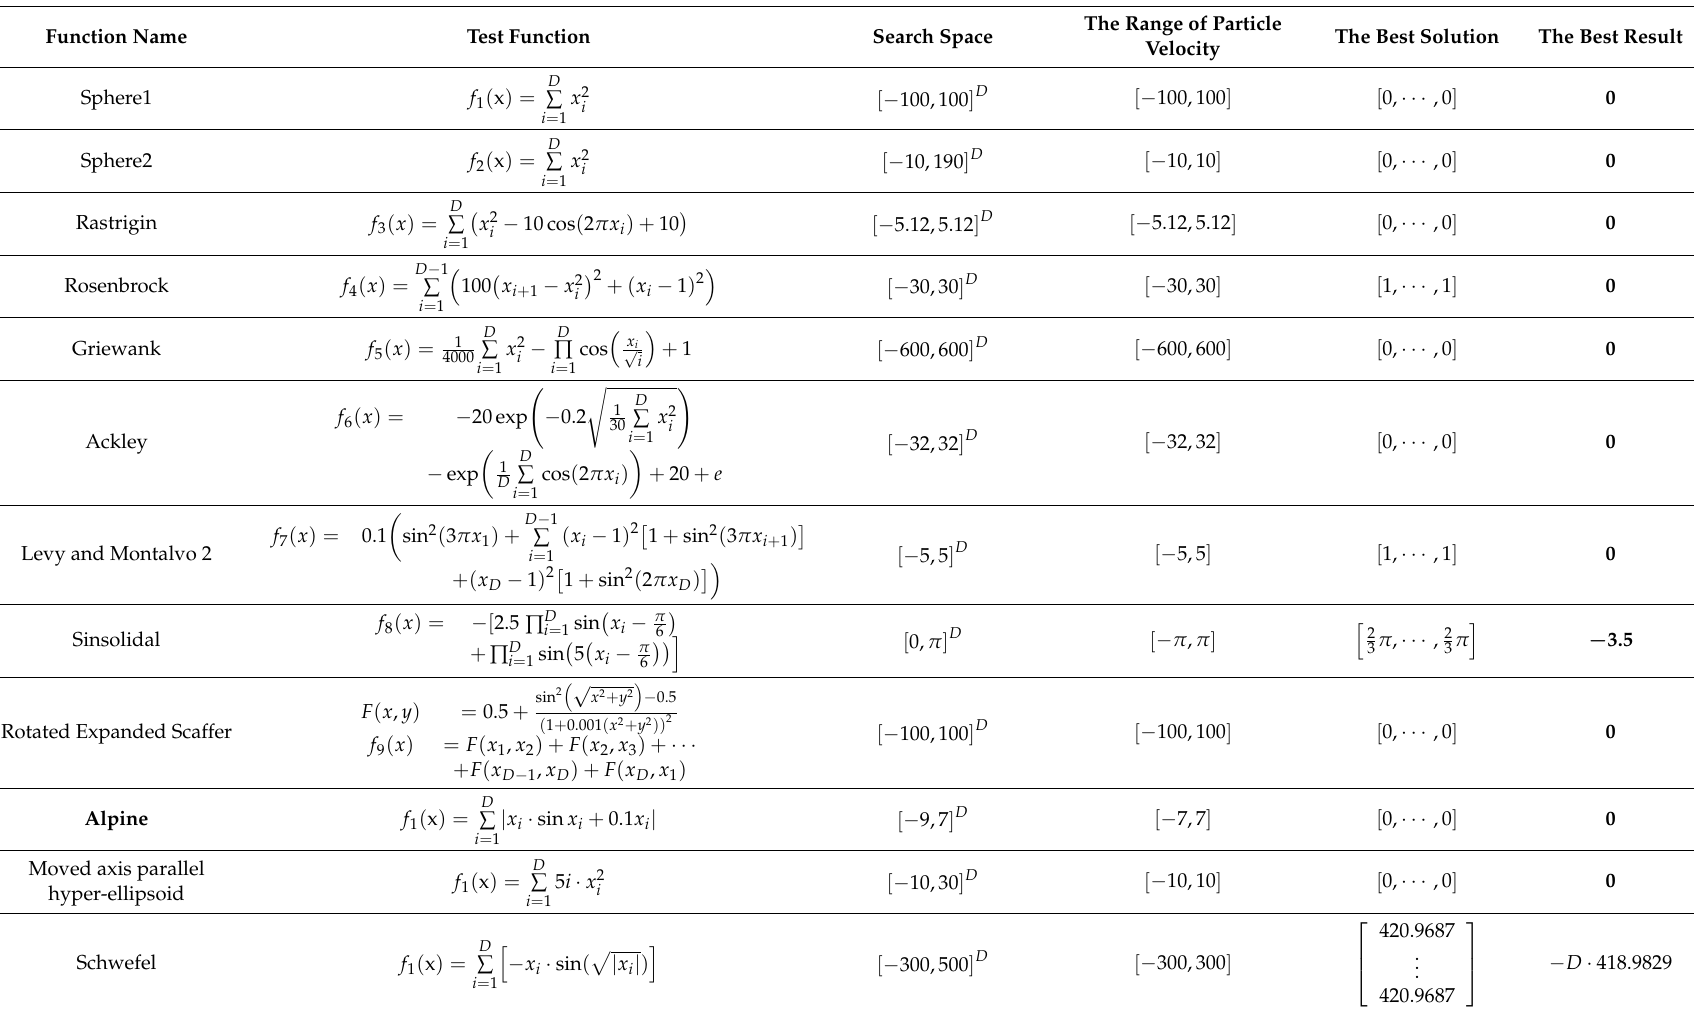
Table 1. Benchmark